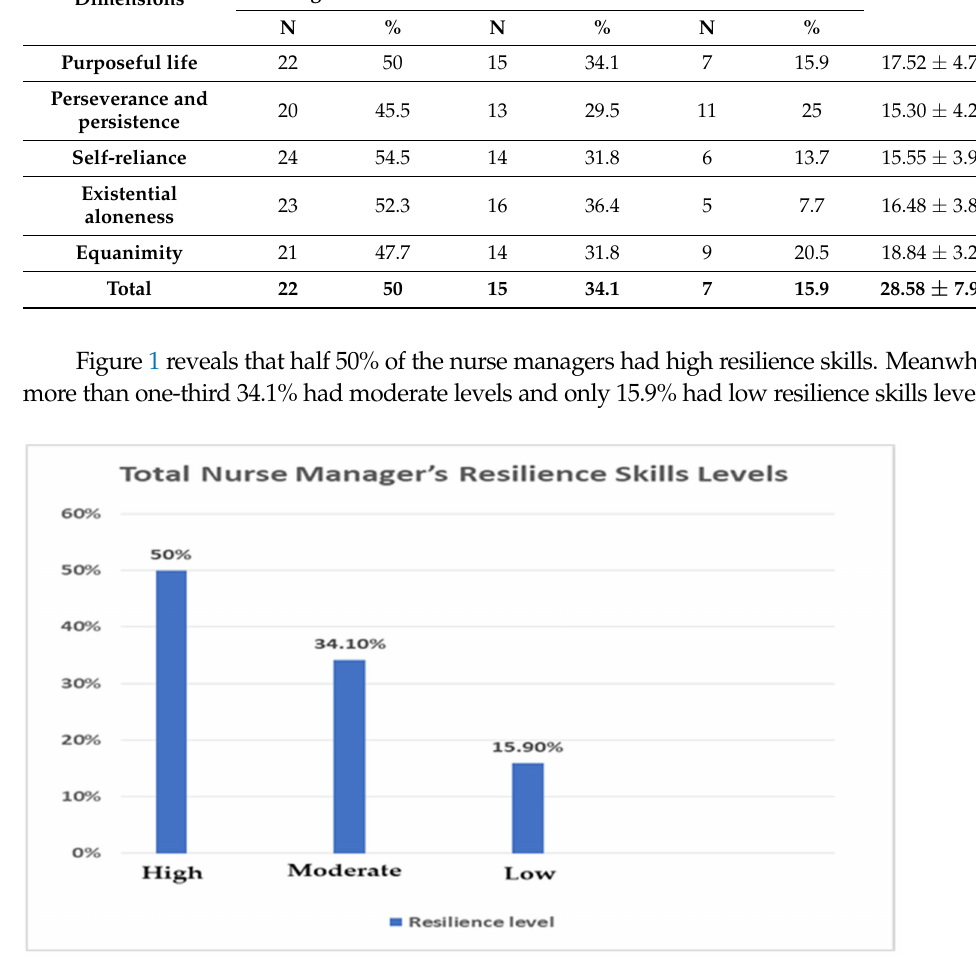
Figure 1. Total nurse manager’s resilience skills levels ( n = 44).